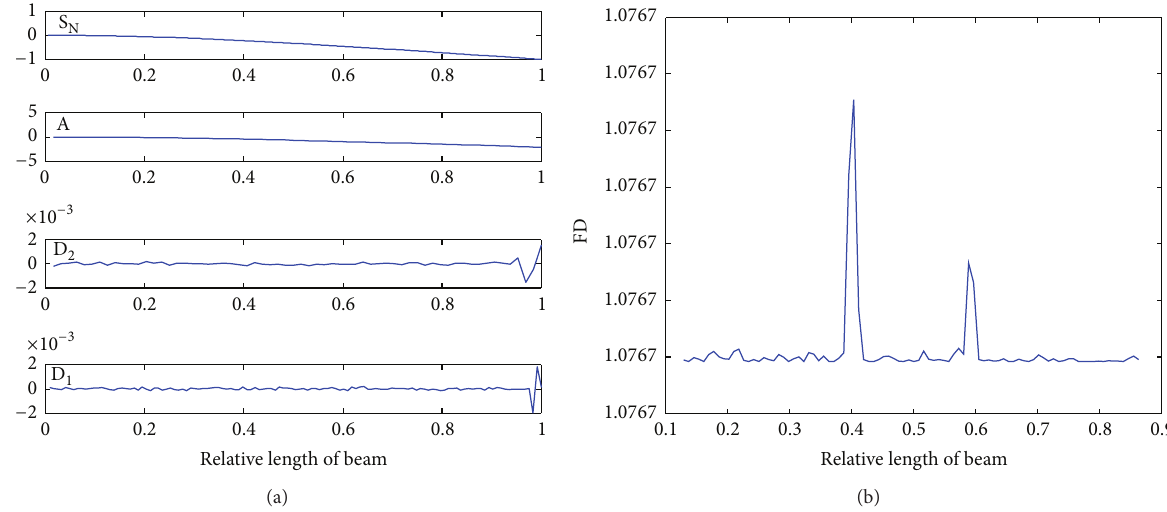
Figure 5: Crack location identification results in 80 dB noise level for the first mode shape. (a) Noise contaminated the first mode shape S N and its wavelet decomposition at level 2. (b) FD of the detailed signal D 1 .